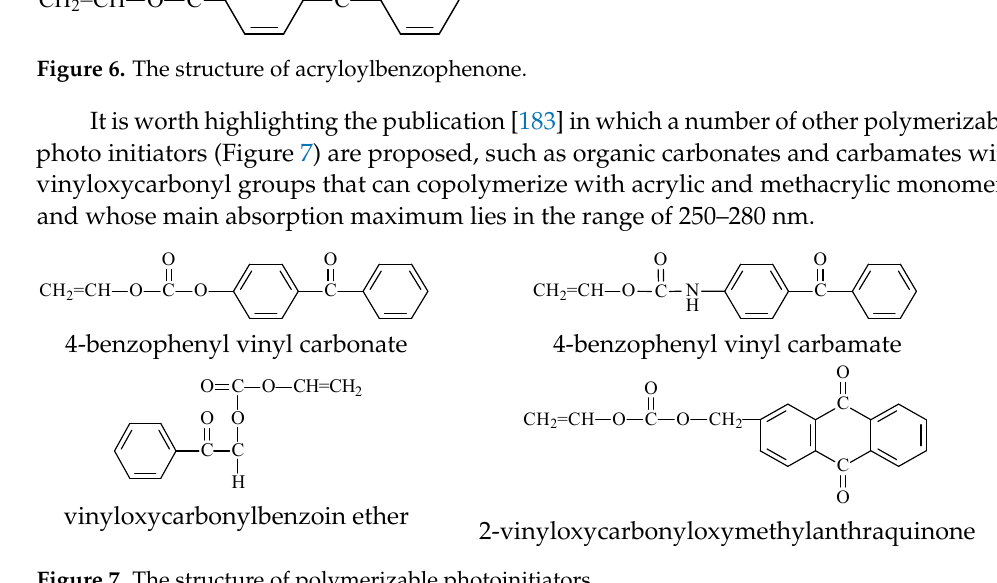
Figure 7. The structure of polymerizable photoinitiators.